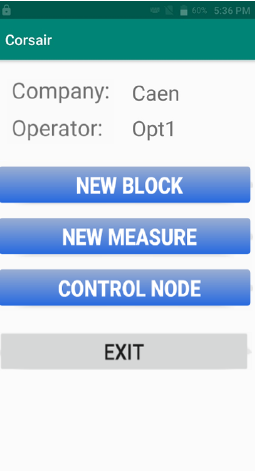
Figure 8. The main user interface of CORSAIR